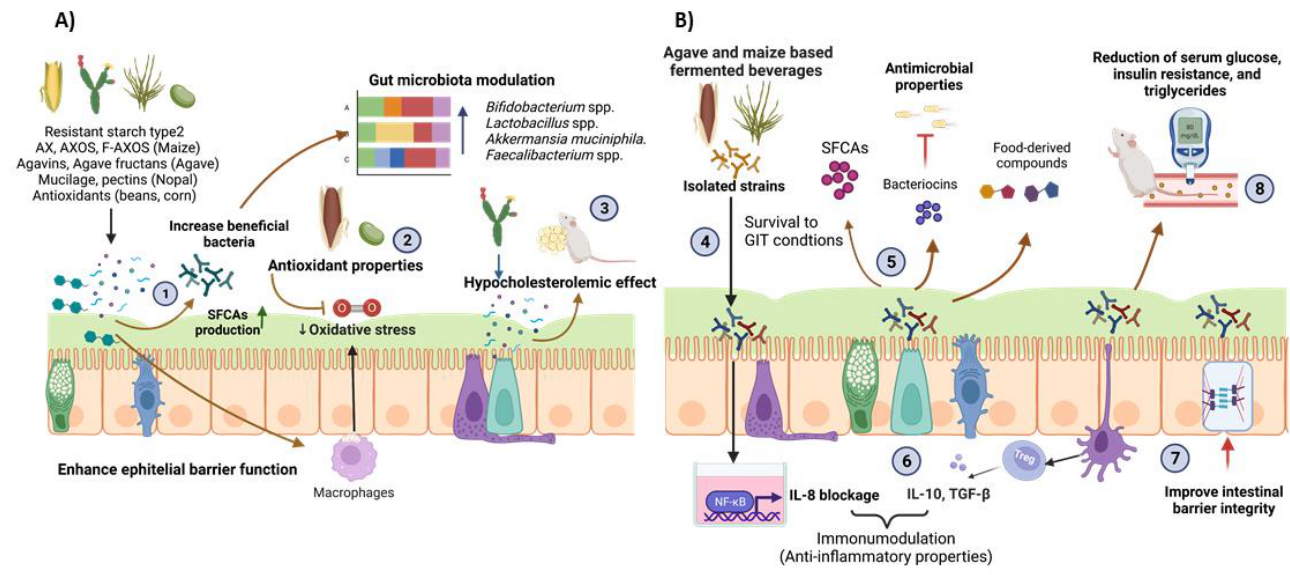
Figure 1. The general mechanisms by which Mexican traditional food can have a health effect are diverse and have been lately described: ( A ) Some of the components of Mexican traditional food, called prebiotics (non-digestible carbohydrates and antioxidants compounds) can exert positive effects on intestinal and systemic health: (1) enhancing the increase in numerous short-chain fatty acids (SCFAs) producing bacteria, butyrate, acetate, propionate, and gut microbiota modulation; (2) displaying antioxidant properties; and (3) improving metabolic syndrome markers such as a decrease in cholesterol. ( B ) The different fermented food containing a proportion of probiotic bacteria that are known to interact with the indigenous host microbiota also have health benefits. Isolated strains from maize and agave-based beverages are capable to survive gastrointestinal conditions, and (5) produce SCFAs and antimicrobial compounds against pathogen bacteria, (6) immune-modulate anti-inflammatory cytokines, (7) reinforce the colon barrier integrity, and (8) improve some metabolic syndrome markers. SCFAs: Short-chain fatty acids. RS: Resistant starch. AX: Arabinoxylans. XOS: Xylooligosaccharides. F-AXOS: Feruloylated arabinoxylan mono- and oligosaccharides. Created by BioRender.com (2022) (accessed on 6 March 2022).